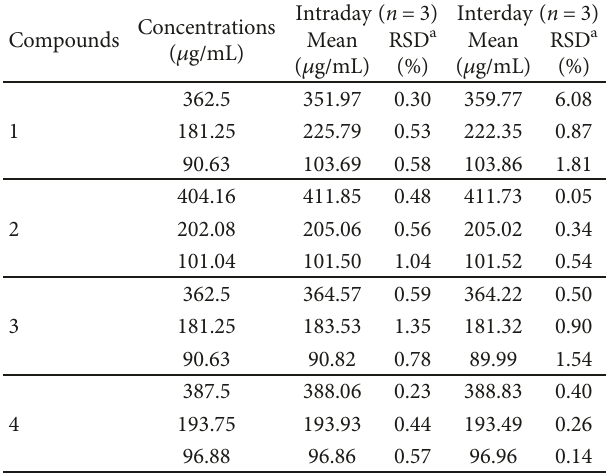
Table 2: Intra- and interday precision of four compounds in the extract of lotus embryo by HPLC-DAD. Neferine